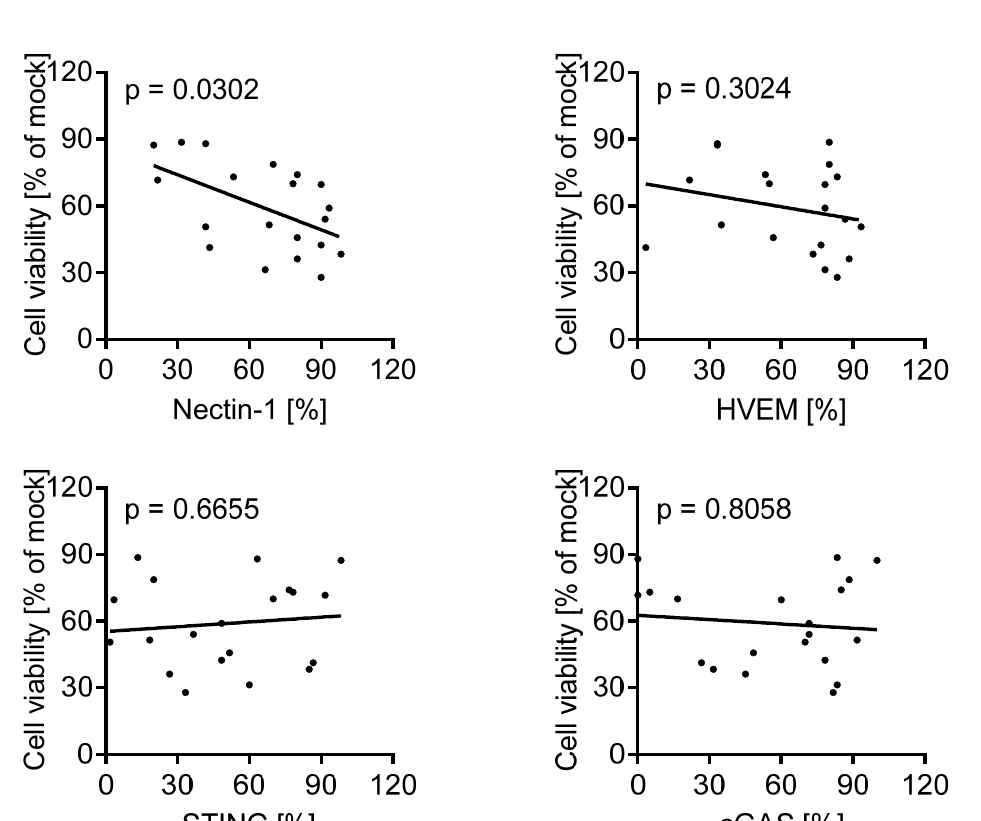
Figure 4. Correlation of biomarkers evaluated by flow cytometry, Western blot, and immunohistochemistry with the oncolytic activity of T-VEC in melanoma cell lines. Spearman correlation coefficient analysis for ( A ) Nectin-1 and HVEM expression, measured by flow cytometry (FACS) and immunohistochemistry (IHC), ( B ) STING and cGAS expression, evaluated by Western blot (WB) and immunohistochemistry, and ( C ) expression of all four biomarkers in immunohistochemistry with the oncolytic activity of T-VEC in 20 melanoma cell lines. Data show the mean of three independent experiments for each biomarker and MTT assay.